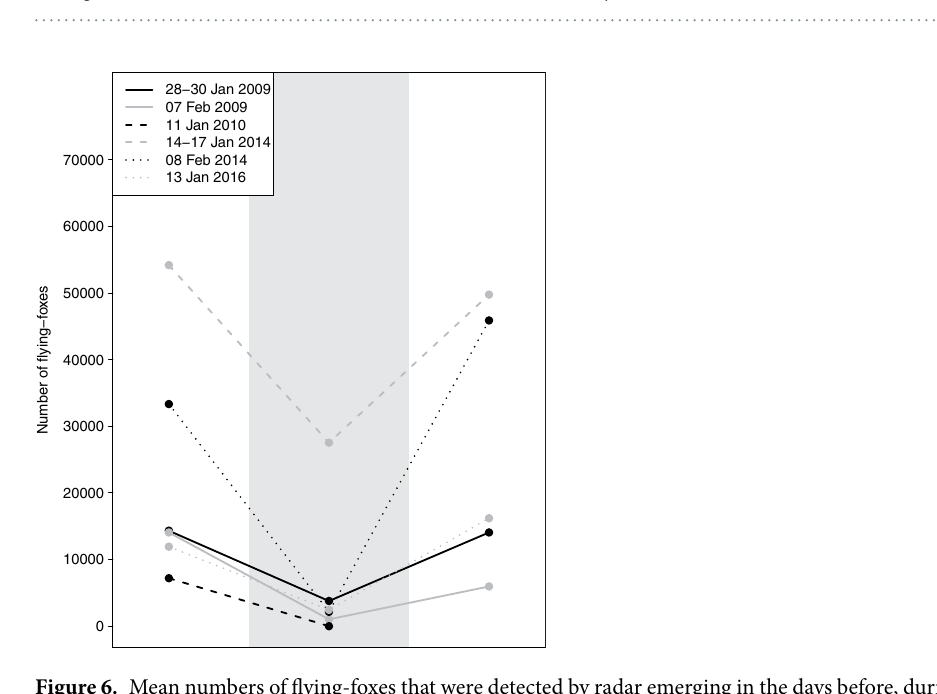
Figure 5. Panel 1: The mean number of flying-foxes detected by radar flying out from the Yarra Bend roost in different directions for each month across all years. Panel 2: The mean monthly departure directions. Data were averaged within each month and then for each month across all years.